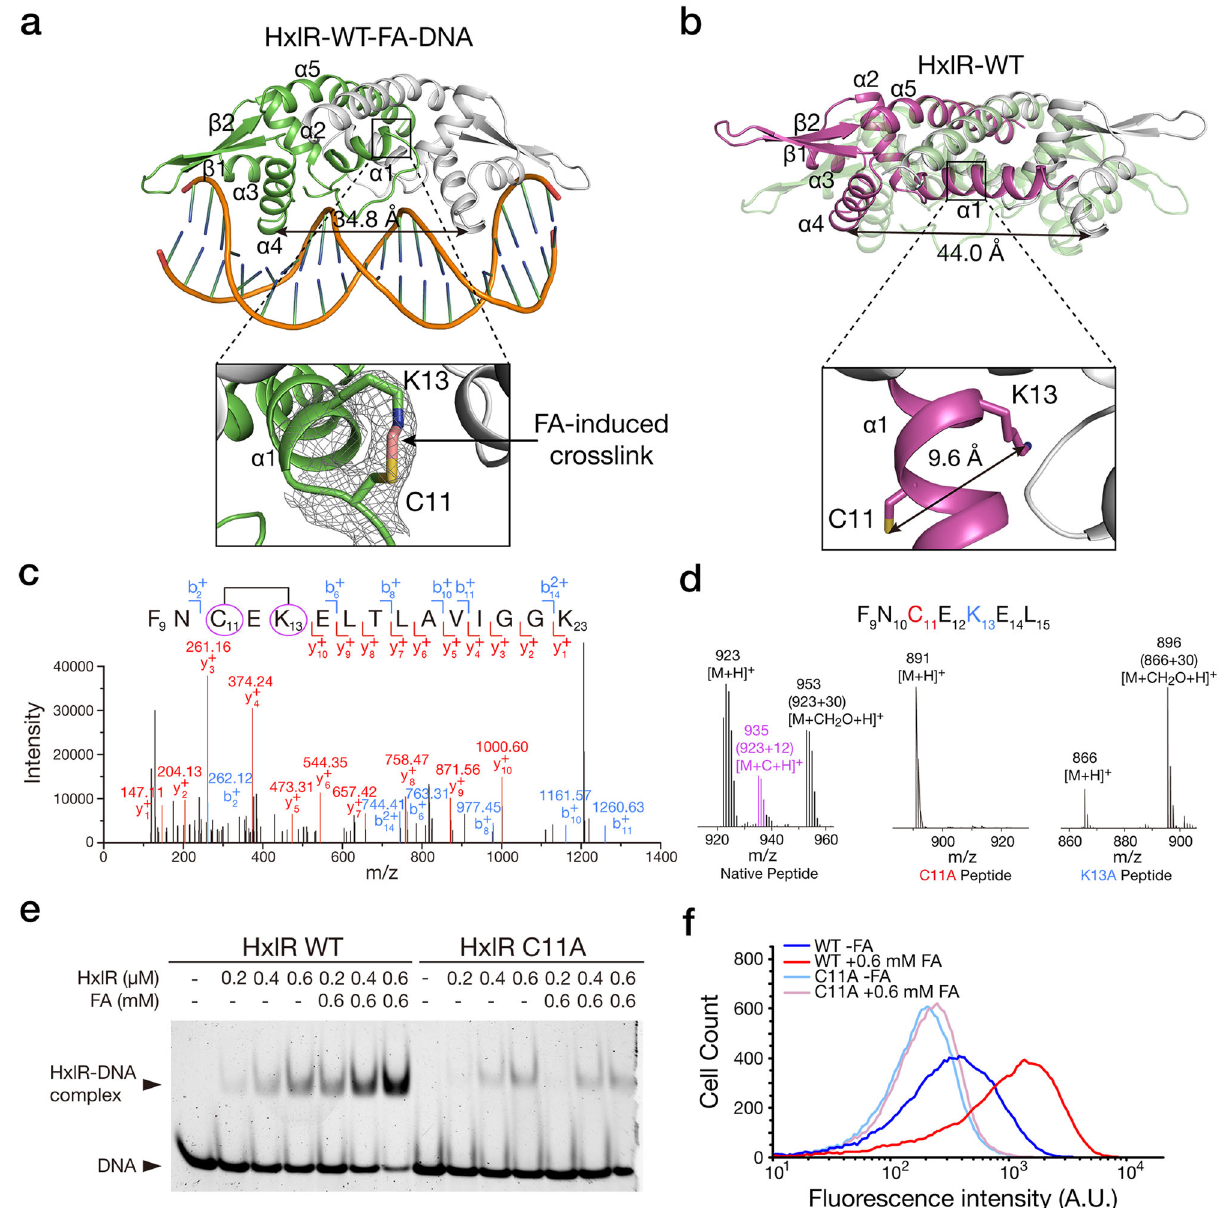
Fig. 1 HxlR directly senses FA via the intrahelical Cys-Lys crosslinking reaction. a Crystal structure of FA-activated HxlR protein/DNA complex (HxlR- WT-FA-DNA). Close-up view (right) shows the FA-triggered crosslinking reaction between residues Cys11 and Lys13 on helix α 1. The 2 F o - F c electron density map contoured at 1 σ indicates that an intrahelical methylene bridge (pink) was formed between Cys11 and Lys13 upon FA treatment. b Crystal structure of HxlR protein in the absence of FA (HxlR-WT). Close-up view (right) shows the side-chains of residues Cys11 and Lys13 which face opposite directions. The distance between the thiol group on Cys11 and the amine group on Lys13 is 9.6 Å, indicating no interactions between these two residues. Superposed structures of HxlR-WT and HxlR-WT-FA-DNA (light green) showed obvious conformational change with FA-induced intrahelical crosslinking reaction. c MS-MS characterization of FA-induced methylene bridge between Cys11 and Lys13 on intact HxlR protein under living conditions. In the MS/MS spectrum of a peptide F9-K23, the fragment ions b2 + and y10 + correspond to the peptide fragments 9 FN 10 and 14 ELTLAVIGGK 23 , respectively (observed m/z 262.12 and 1000.60), which veri fi ed the methylene bridge formation between Cys11 and Lys13 ( + 12 Da, highlighted by purple circles and the black line between them). d LC-MS analysis verifying the FA-induced methylene bridge between Cys11 and Lys13 on a peptide sequence derived from HxlR ’ s helix α 1. Mutation of either Cys11 or Lys13 abolished the methylene bridge formation ( + 12 Da, the [M + C + H] + ion). e Cys11 is essential for FA-enhanced DNA binding of HxlR. Determination of HxlR ’ s DNA-binding ability via EMSA showed that 0.6 mM FA was able to increase DNA-binding ability of HxlR-WT protein, whereas little change was observed for the HxlR-C11A mutant, in the presence of FA. f Flow cytometric analysis of the hxlAB - gfp reporter-harbored E. coli BW25113 cells expressing HxlR-WT or HxlR-C11A proteins with and without FA treatment. The addition of 0.6 mM FA increased the expression level of GFP in the bacterial strain expressing HxlR-WT, while little change was observed on the bacterial strain expressing HxlR-C11A, indicating that Cys11 is essential for FA-enhanced transcription activity of HxlR in vivo.